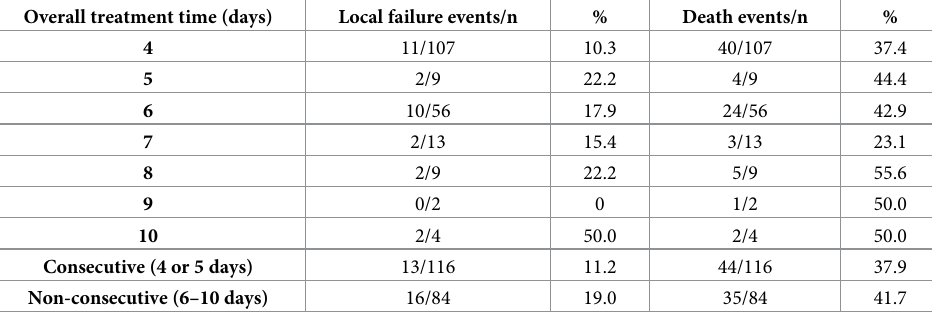
Table 2. Crude event rates of local failure and death according to the overall treatment time. Overall treatment time (days)